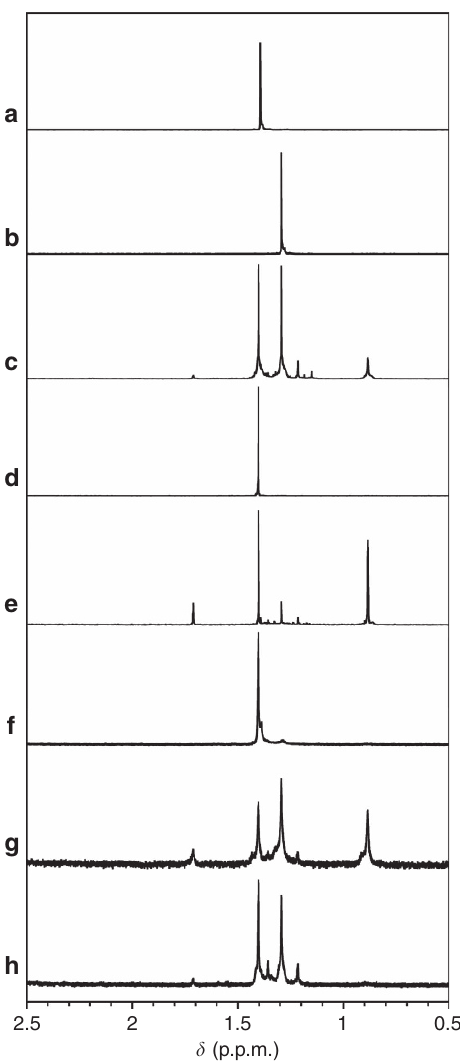
Figure 7 | 1 H NMR spectra of PHER products in the presence of hydrogen radical scavengers. 1 H NMR spectra (MeOH- d 4 ) of ( a ) t -BuSH, ( b ) t -Bu 2 S 2 , ( c ) t -Bu 2 S 2 after photoirradiation at 289 ± 10nm (5h), ( d ) t -BuSH with apH 2 , ( e ) t -BuSH with apH 2 after photoirradiation at 289 ± 10nm (5h), ( f ) t -BuSH with 1 , ( g ) t -BuSH with 1 after photoirradiation at 289 ± 10nm (5h) and ( h ) t -BuSH with 1 after photoirradiation at 350 ± 10nm